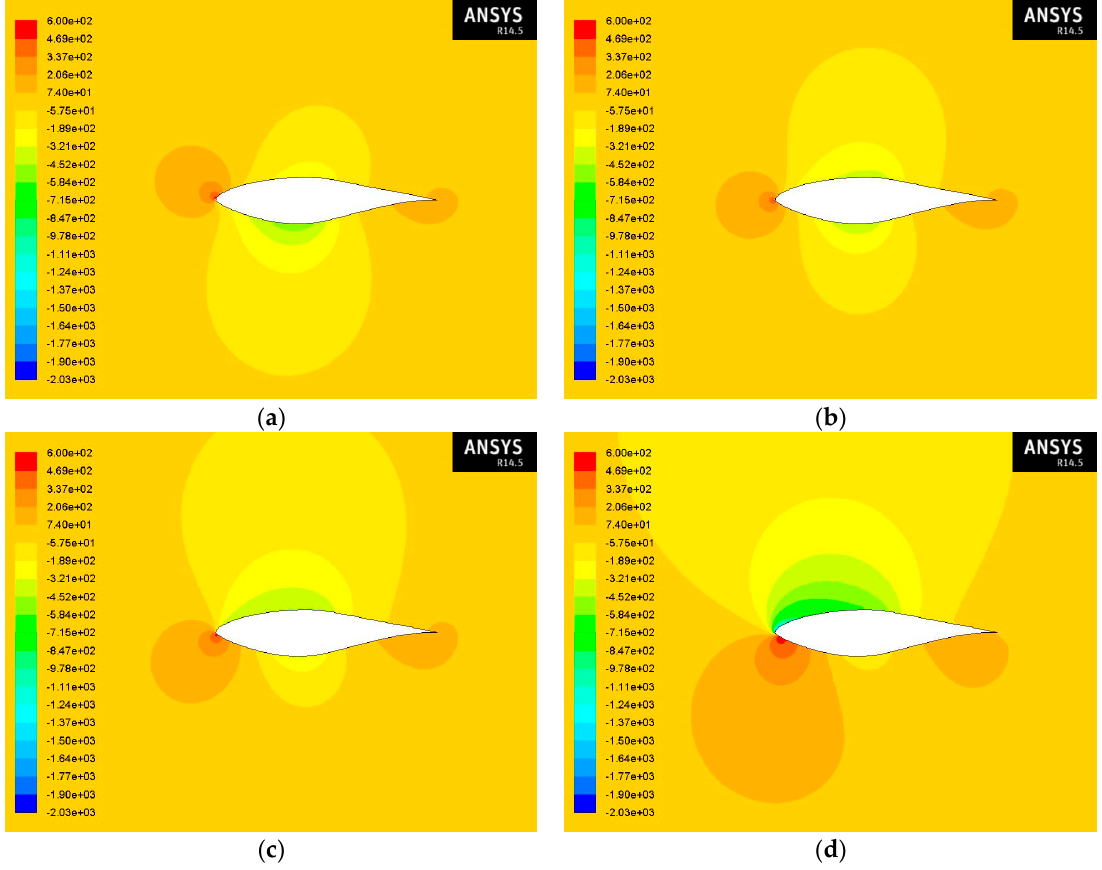
Figure 11. Contours of static pressure at ( a ) − 3°; ( b ) 0°; ( c ) 3°; and ( d ) 9° angles of attack at Re = 2 × 10 6 with the realizable k– ε turbulence model for an S809 airfoil for air-sand particle two-phase flow and 1% concentration of sand particles in the air.